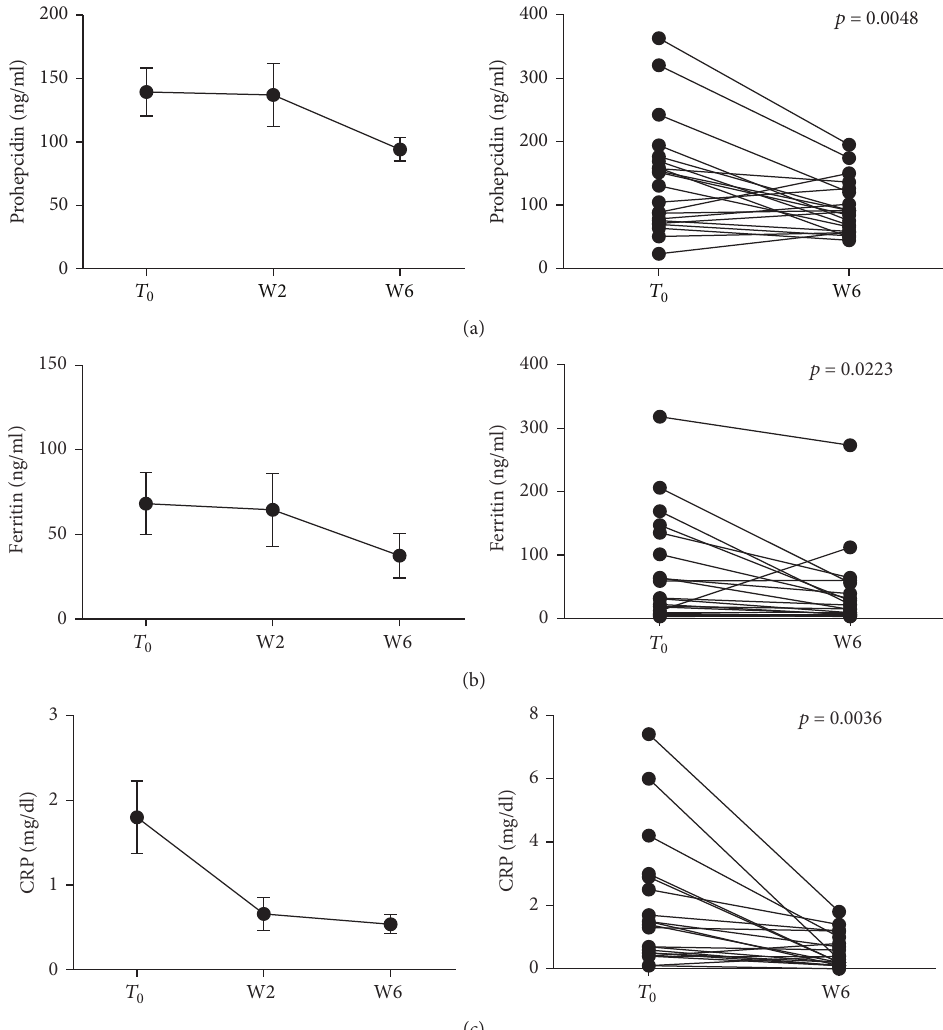
Figure 2: Prohepcidin and acute phase protein levels during anti-TNF therapy. Serum samples were collected before each anti-TNF administration and prohepcidin, ferritin, and CRP circulating levels measured. Statistical analysis was performed using Student’s 𝑡 -test for paired data. Data are presented as single data point or as mean ±